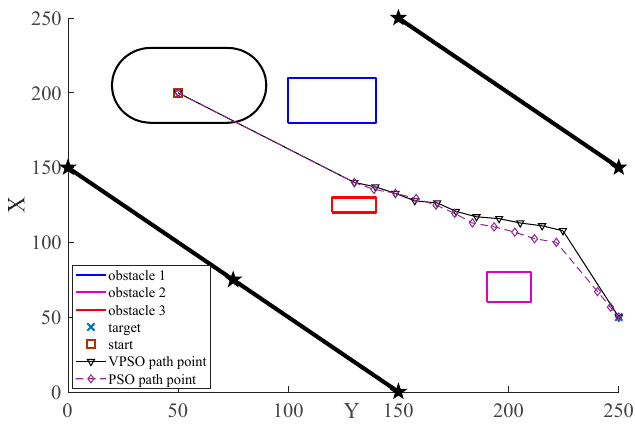
Figure 12. Simulation of the roadheader’s rectification path plan. Table 4. The roadheader’s rectification path plan parameter.